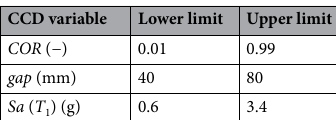
Table 1. Bounds of the CCD